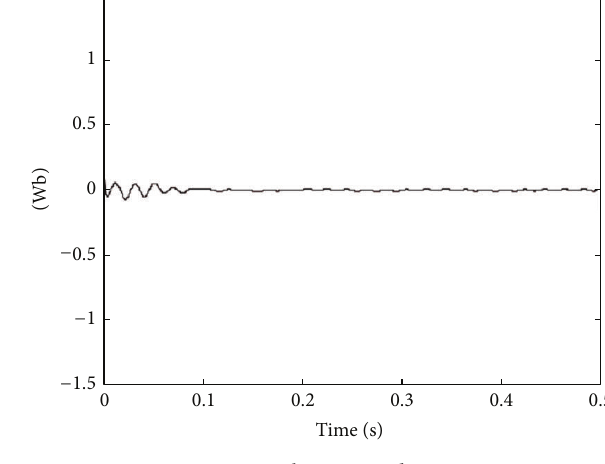
Figure 6: Flux error in 𝑏 -axis.